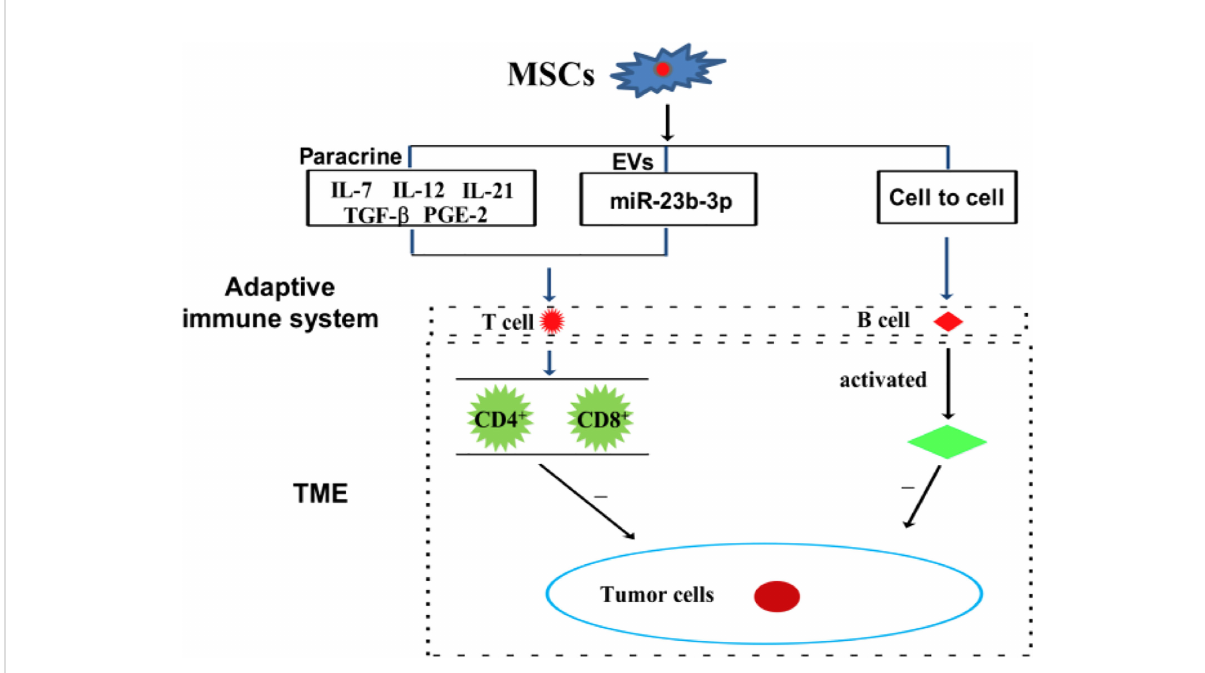
FIGURE 4 MSCs can modulate adaptive immune cells through the mechanism of paracrine pathway, EVs, and cell to cell